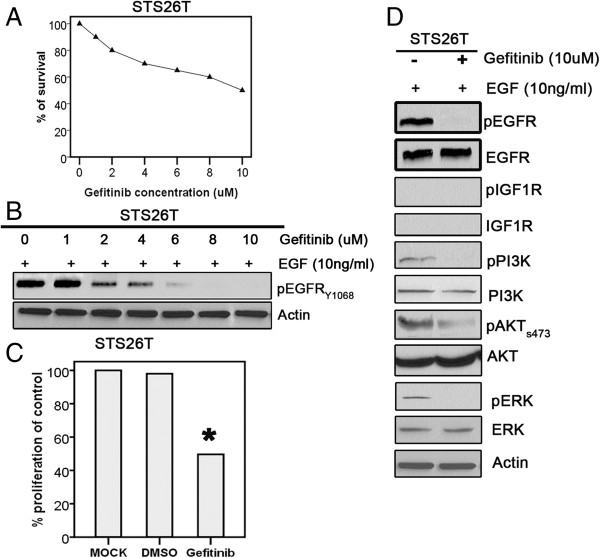
EGFR kinase inhibitor gefitinib decreased STS26T MPNST tumor cell proliferation by blocking the PI3K/AKT and MAPK pathways. (A) The IC50 of gefitinib in tumor cells was about 10 μM. (B) At a 10-μM concentration, gefitinib significantly decreased tumor cell proliferation compared with the MOCK and DMSO controls. (C) Gefitinib significantly decreased activation of EGFR. (D) Gefitinib significantly decreased activation of the PI3K/AKT and MAPK signaling pathways. * indicate P-values <0.05.